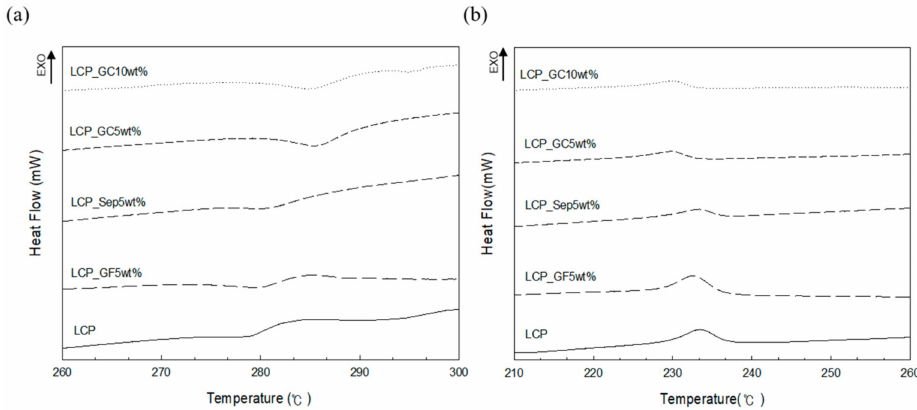
Figure 5. DSC curves of the LCP composites: ( a ) heating and ( b ) cooling.